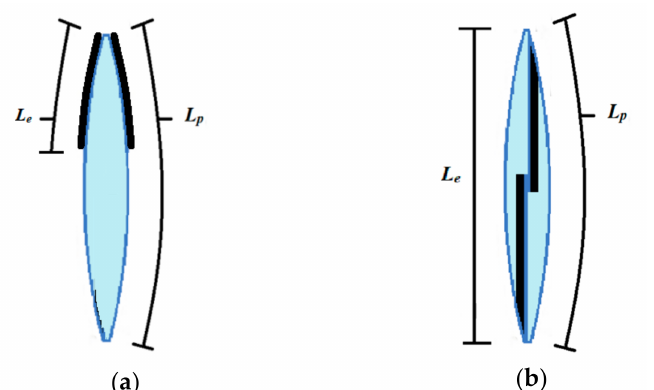
Figure 8. (Above) [3] ( a ) Depiction of the electrode coverage for the peano HASEL design with the zip mechanism. ( b ) Depiction of the electrode coverage of the sliding